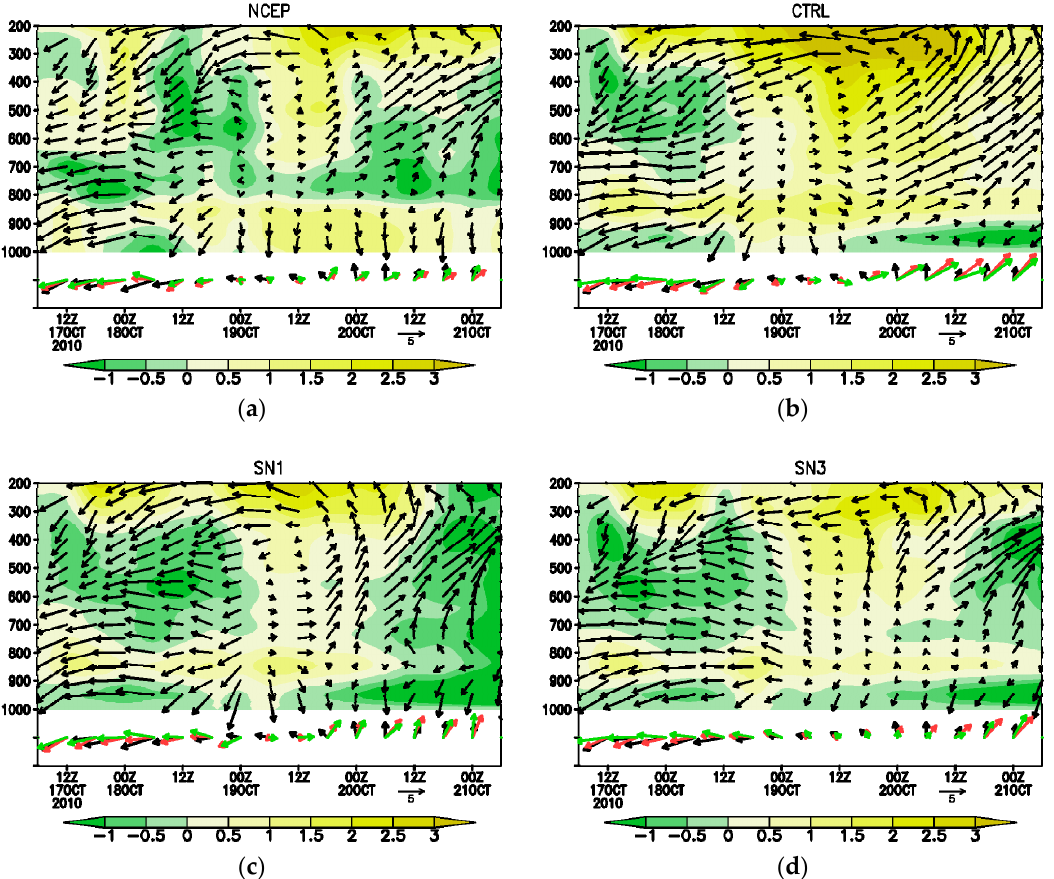
Figure 4. Temporal-spatial evolution of environmental mean wind (black wind vector, units: ms − 1 ), temperature anomaly in the core area (dashes, units: K) and steering flow (wind vectors, units: ms -1 ) in ( a ) NCEP, ( b ) CTRL, ( c ) SN1 and ( d ) SN3. The environmental mean wind is calculated by 10° × 10° rectangle area centering at the typhoon center. The temperature anomaly is the difference of the mean temperature in the core area (2° × 2°) between the present time and initial time. Black wind vectors below represent the average direction vectors by six hours by observation. Red and green vectors respectively represent steering flow of the whole troposphere (850–300 hPa) and lower troposphere (800–600 hPa).